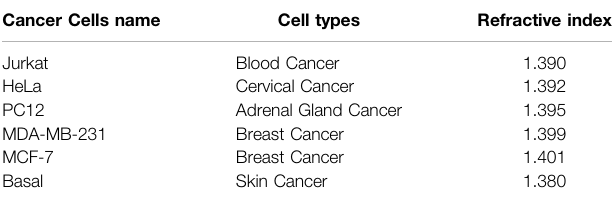
TABLE 1 | Different cancer cells and their corresponding